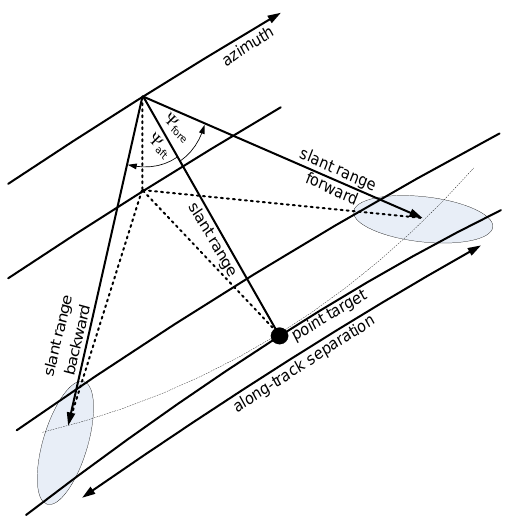
Figure 8. Bidirectional synthetic aperture radar (BiDi) acquisition geometry example with simultaneous fore and aft acquisitions.